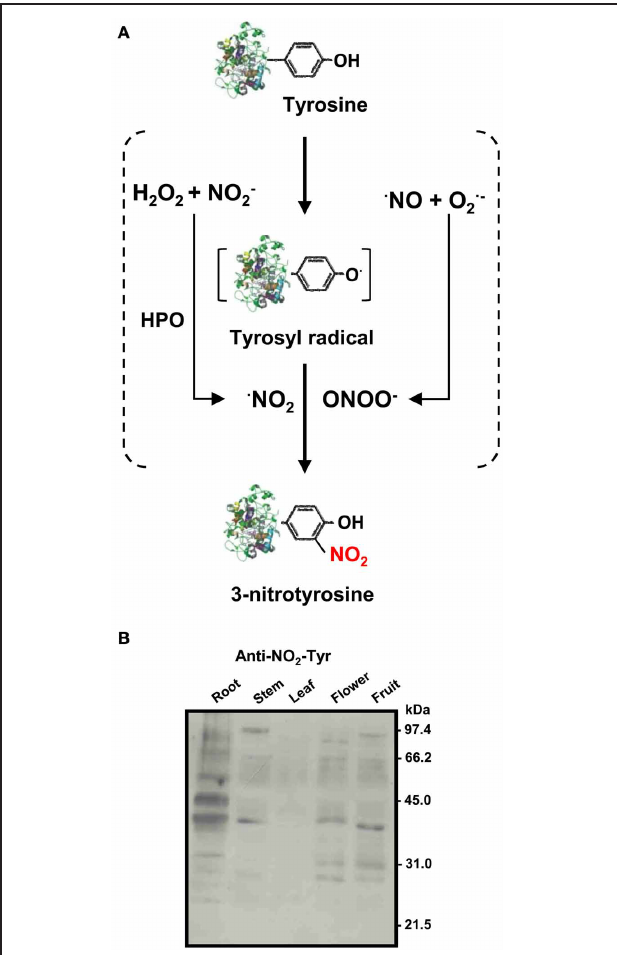
FIGURE 1 | (A) Biochemistry of protein tyrosine nitration (NO 2 -Tyr). Tyrosine nitration involves two steps: oxidation of the phenolic ring of tyrosine to tyrosyl radical (Tyr · ) and addition of · NO 2 to the Tyr · by a nitrating agent. The Tyr radical can be produced by several one-electron oxidants such as · NO 2 , · OH, or CO ·− 3 . There are two main nitrating reactions: (1) by peroxynitrite (ONOO − ) which is formed by the quick reaction between nitric oxide ( · NO) and superoxide (O ·− 2 ) radicals; and (2) By · NO 2 produced by reaction of hydrogen peroxide (H 2 O 2 ) and nitrite (NO − 2 ) in the presence of hemoperoxidase (HPO) (Souza et al., 2008). (B) Representative immunoblot showing the pattern of protein tyrosine nitration (NO 2 -Tyr) in different organs (root, stem, leaf, flower, and fruit) of pea plants after 71 days of growth under optimal conditions. The numbers on the right side of the immunoblots indicate the relative molecular masses of the protein markers (reproduced from Corpas et al.,